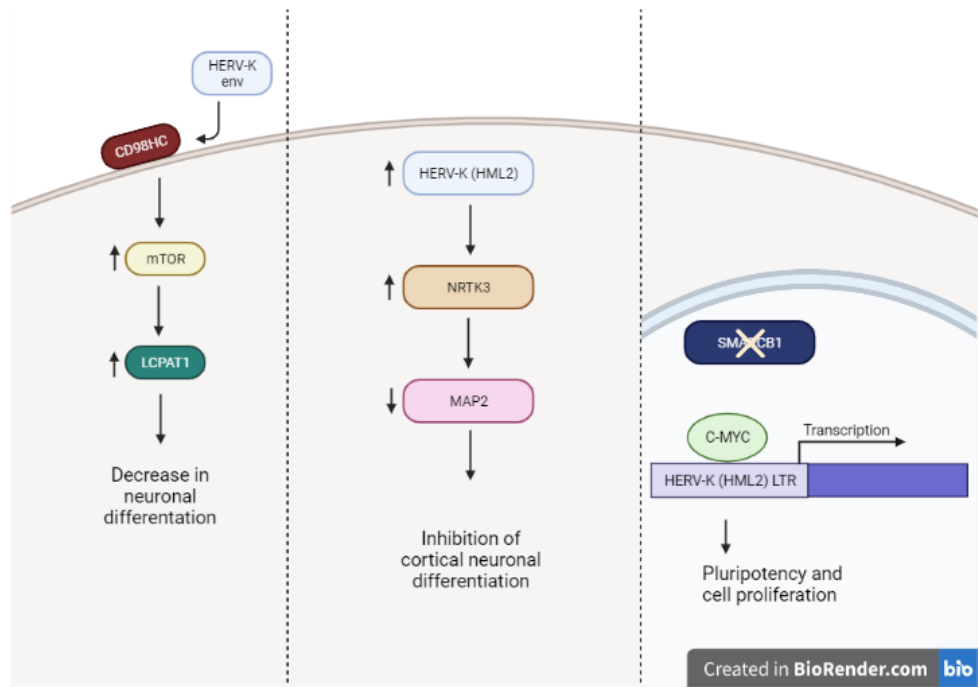
Figure 2. Proposed mechanisms of HERV-K expression and stemness in neurons. Exogenous HERV- K env mediates stemness by binding to CD98HC, which regulates mTOR-LPCAT1 pathway. Addi- tionally, increased HERV-K (HML-2) expression increases NRTK3, after which a decrease in neu- ronal marker MAP2 is observed, promoting an undifferentiated state. Finally, in AT/RT cells, loss of transcription factor SMARCB1 allows binding of C-MYC to HERV-K LTR, promoting features characteristic of pluripotency and proliferation. Made with